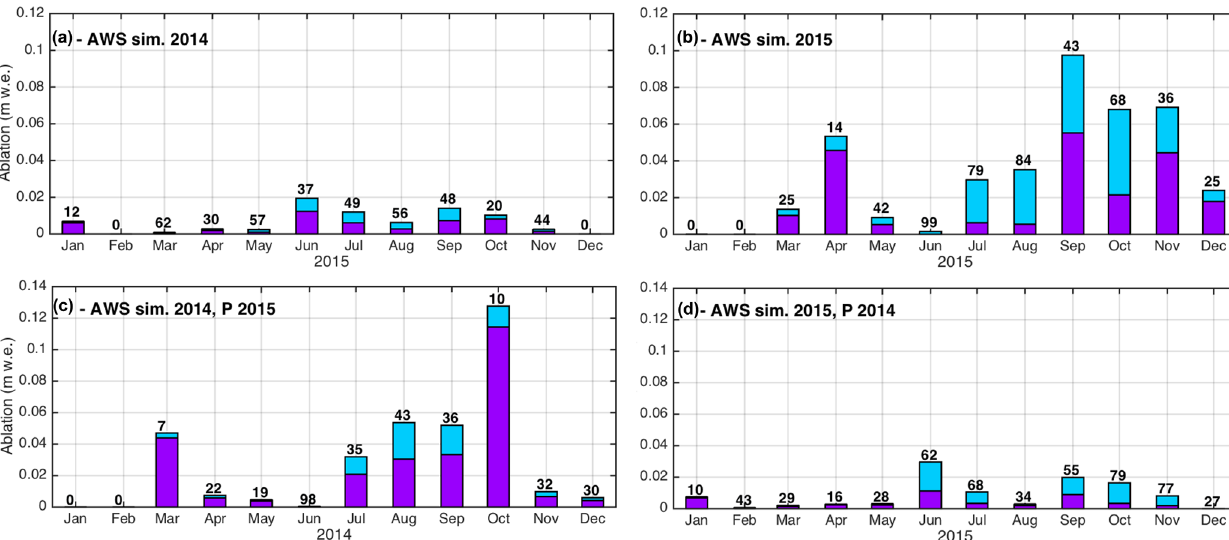
Figure 12. Monthly simulated melt (purple) and sublimation (blue) using AWS forcing (a, b) and AWS forcing with (c) 2015 precipitation (“wet forcing”) and (d) 2014 precipitation (“dry forcing”). Back numbers indicate the monthly sublimation ratio in